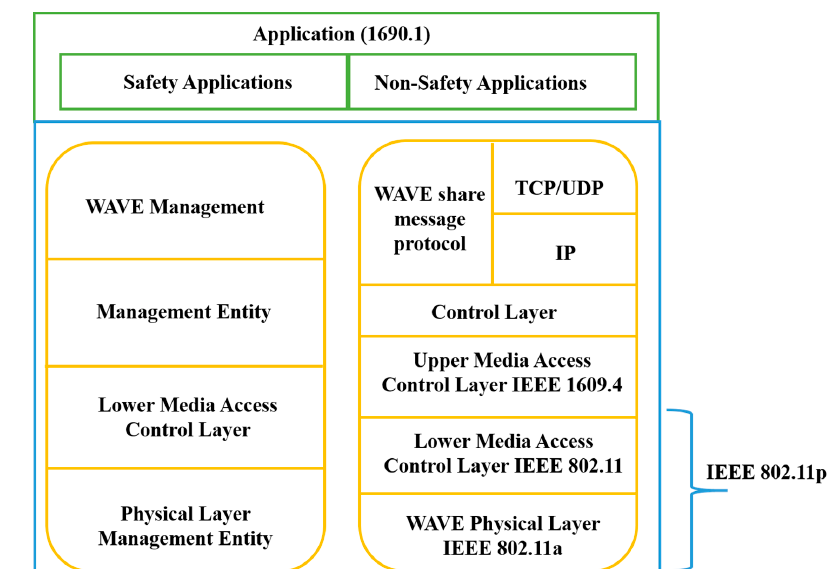
Figure 2. Channel diagram of dedicated short range communication (DSRC).